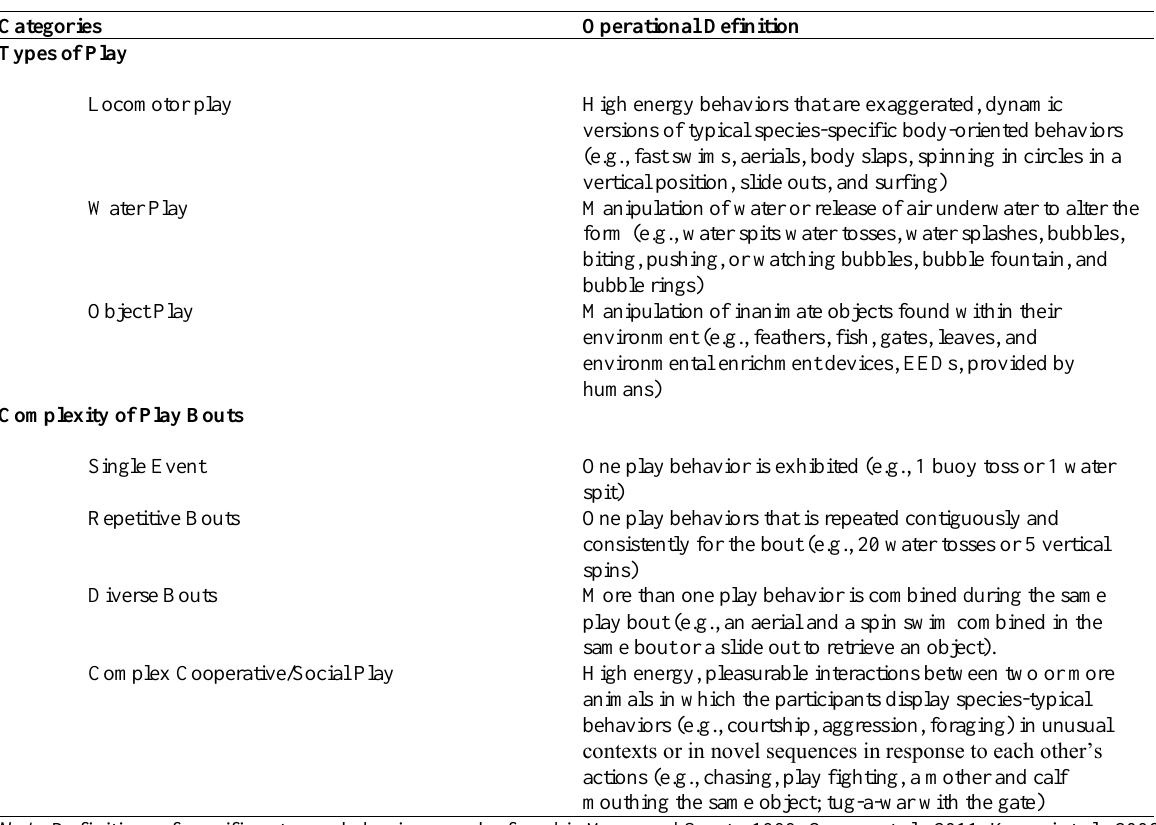
Operational Definitions of Types of Play and Complexity of Play